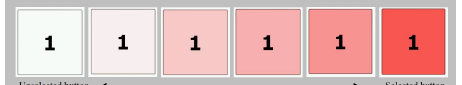
Figure 2 . Dwell-time button color animation, using hue volume to indicate the remaining time before selection.